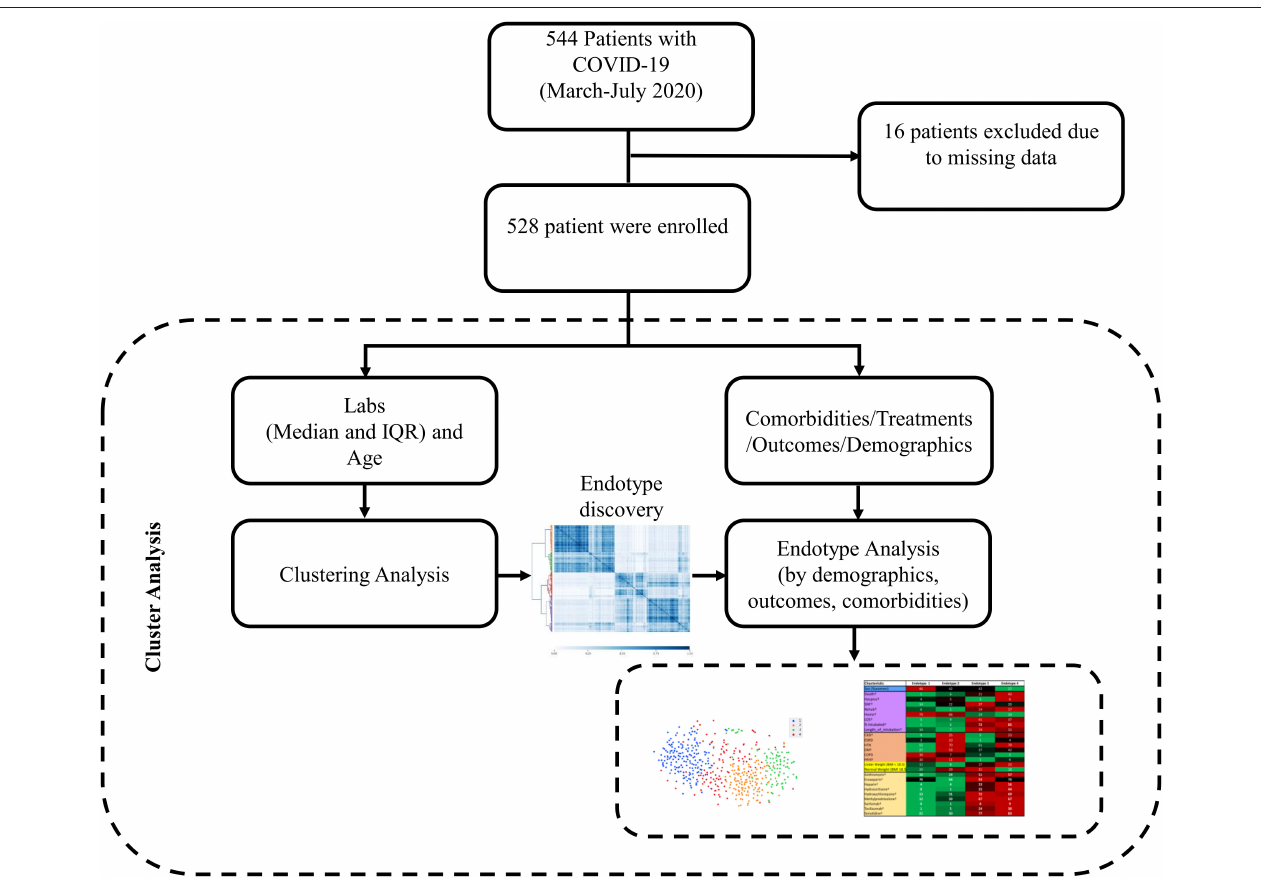
FIGURE 1 | Data collection and analysis schematic. Patients with positive SARS-COV-2 tests that were discharged between March 12, 2020 to July 15, 2020 were included in the study. Labs during hospitalization (median and IQR) and age were the features used for clustering and endotype discovery. Once endotypes were identified, they were analyzed for differences in demographics, outcomes, comorbidities, and